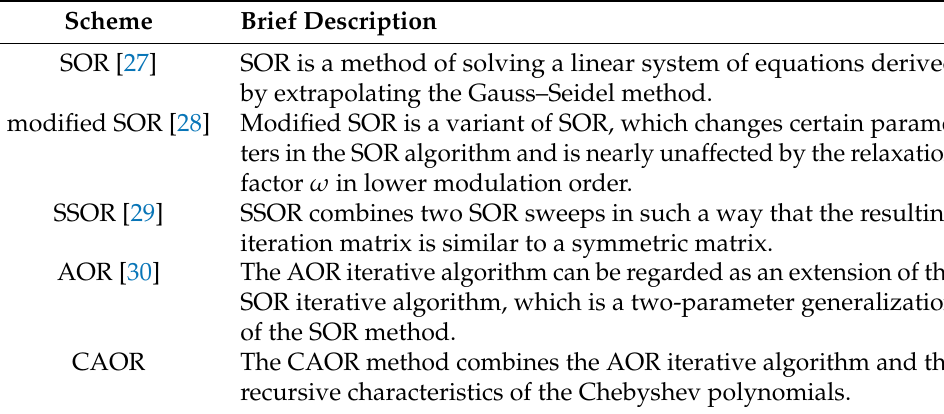
Table 2. A brief comparison of our proposed scheme and previously published